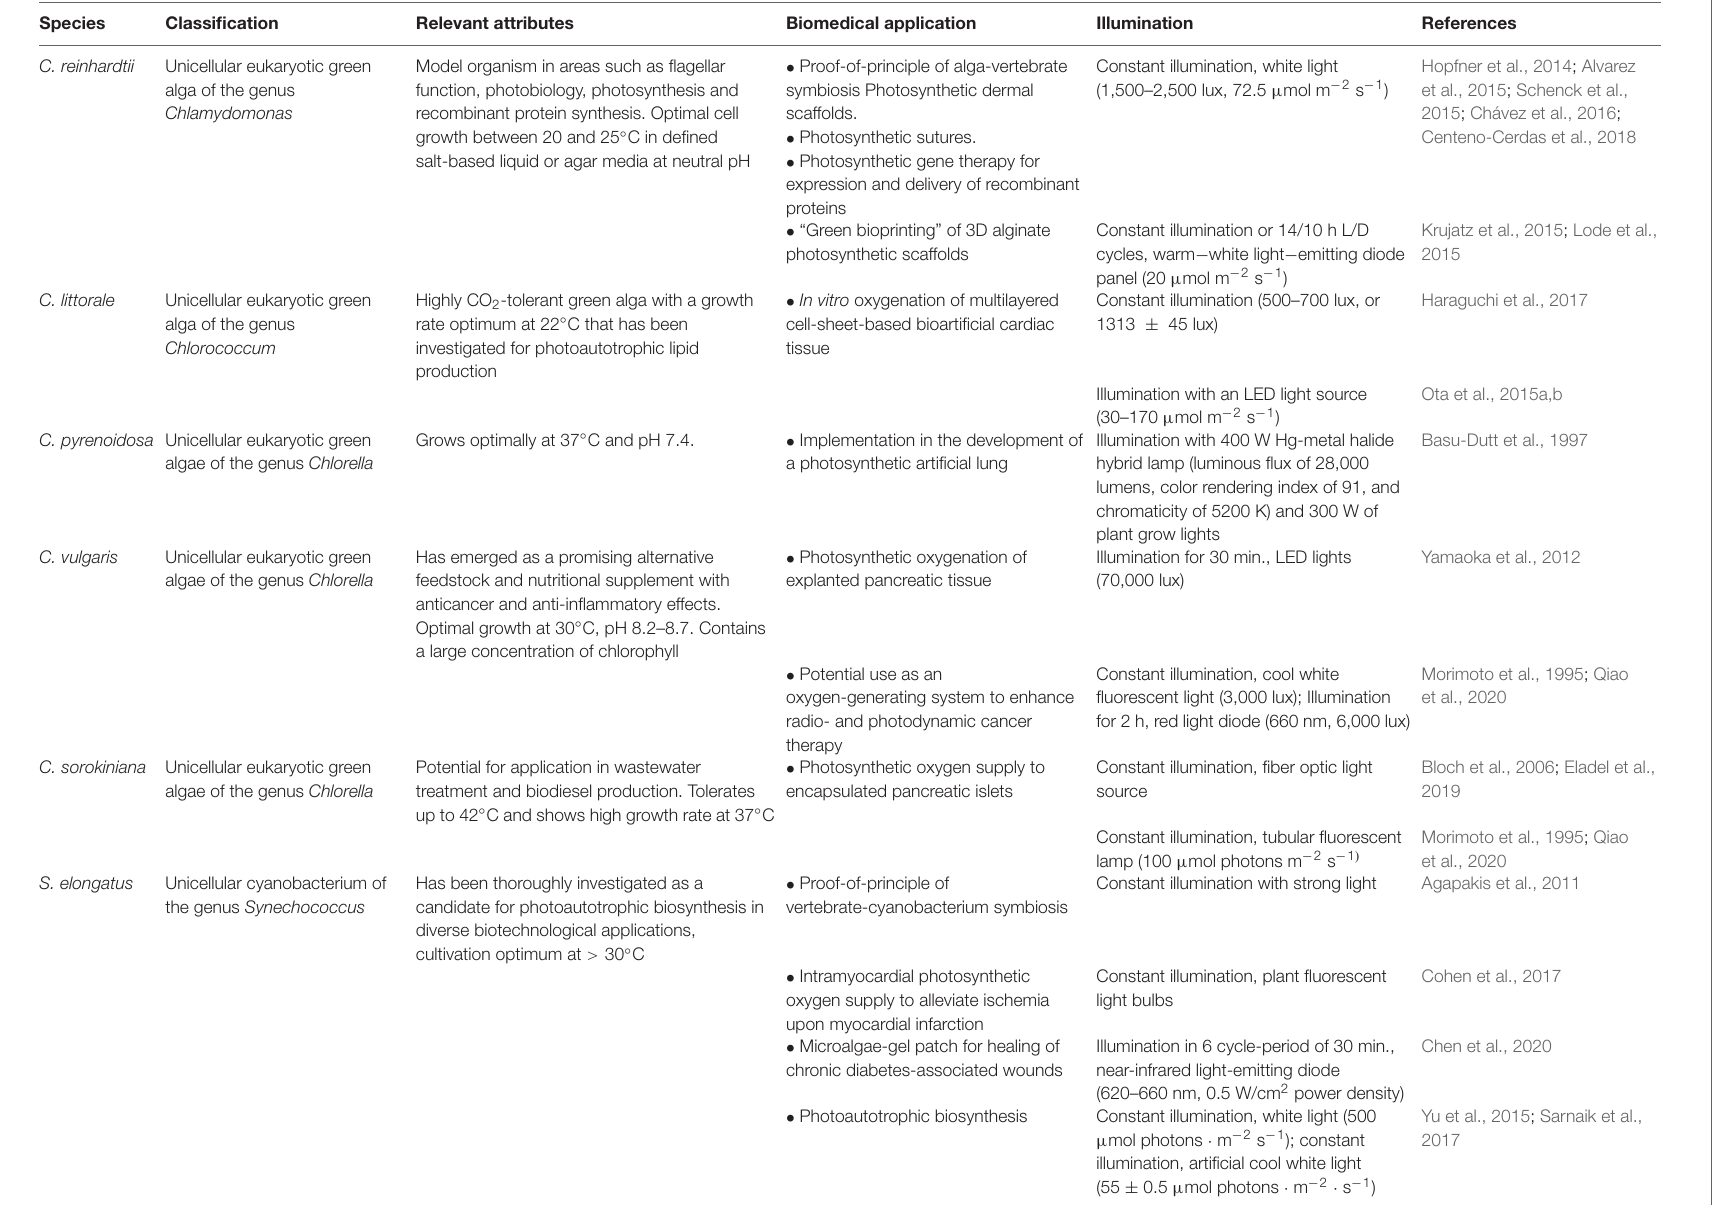
TABLE 1 | Organisms employed for photosynthetic oxygenation in medical